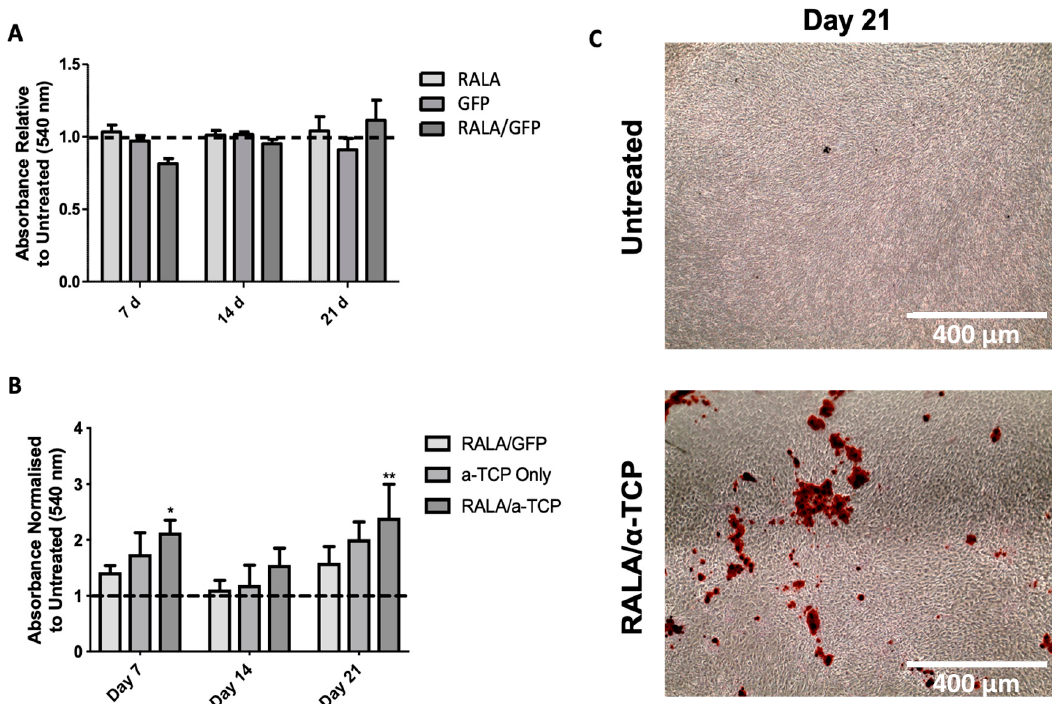
Figure 6. Mineralization of porcine mesenchymal stem cells (pMSC) extracellular matrix. ( A ) cetylpyridinium chloride (CPC) extraction and quantification of mineralized matrix of alizarin red stained pMSC extracellular matrix after transfection with RALA only, GFP only and RALA / GFP NPs in a 24-well plate. ( B ) CPC extraction and quantification of mineralized matrix of alizarin red stained pMSC extracellular matrix after transfection with RALA / GFP, α -TCP only and RALA / α -TCP in a 24-well plate. ( C ) representative images of untreated and RALA / α -TCP treated pMSC 21 days after transfection (magnification 4 × ). (N = 3 ± SEM) * = p < 0.05, ** = p < 0.01.